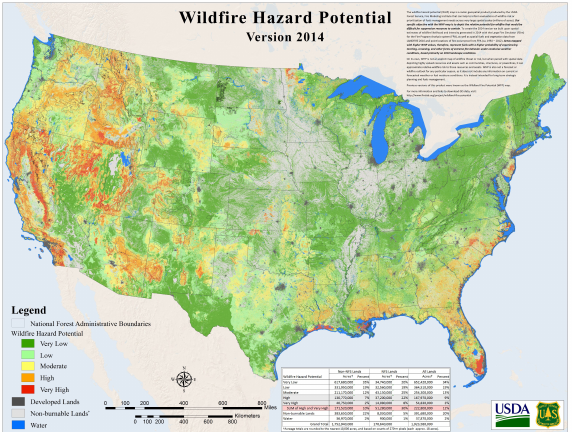
Figure 6. Wildfire potential estimated by USDA Forest Service